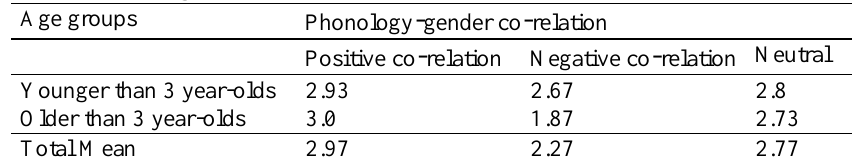
Table 5. Mean correct responses as a function of age and phonology- -gender co-relation (Max Score=3)